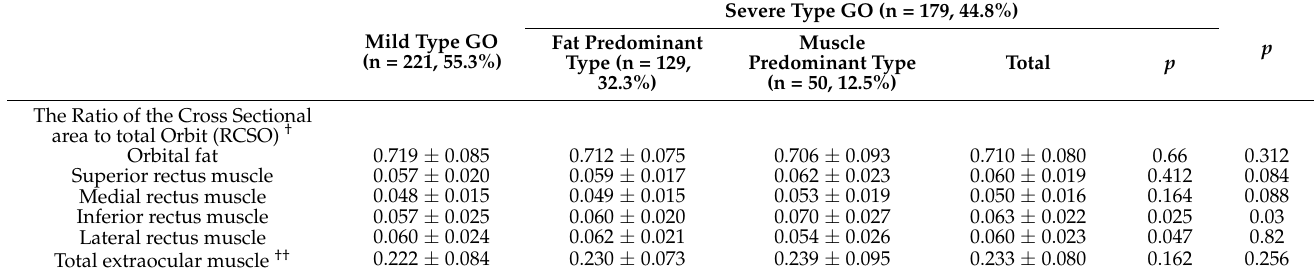
superior rectus muscle + medial rectus muscle + inferior rectus muscle + lateral rectus muscle.